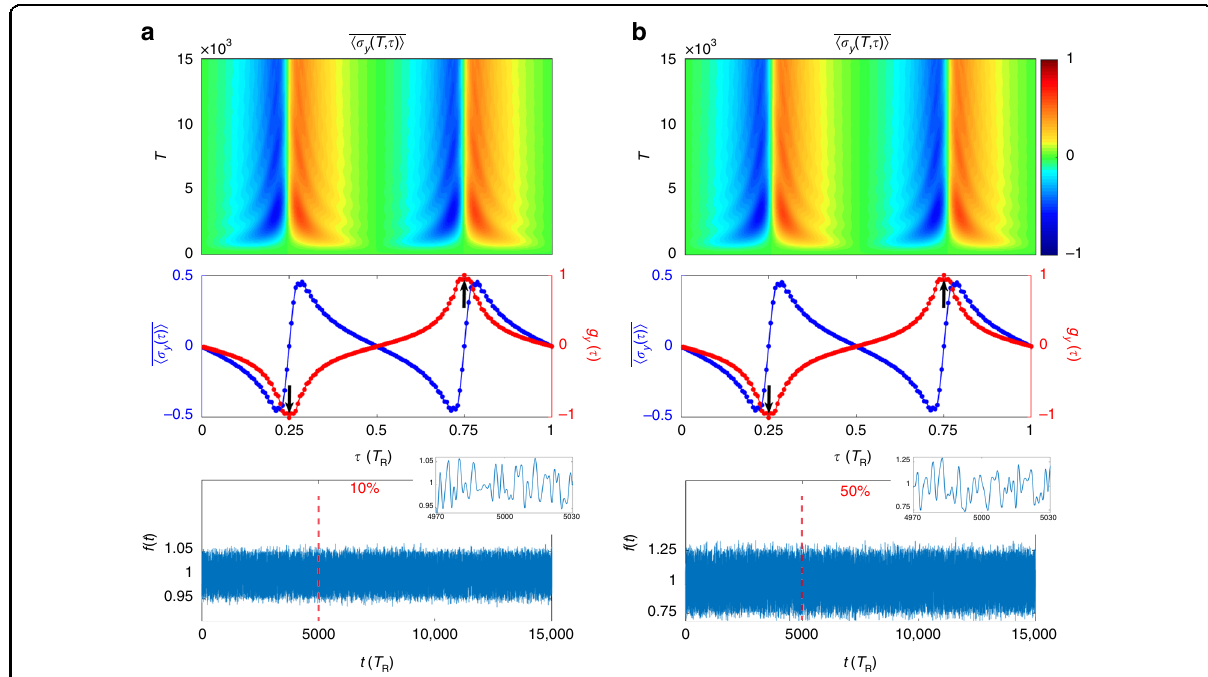
Fig. 4 The time evolution of the normalized spin textures with disorders in the phase modulator. The evolution of averaged spin polarization h σ y ð T ; τ Þi , the overall spin polarization h σ y ð τ Þi , the dynamical spin texture g y ð τ Þ , respectively, with parameters for Fig. 3a, b and disorder function f ð t Þ in κ ð t Þ and κ ′ ð t Þ with δ ¼ 10 % ( a ) and 50 % ( b ), respectively. Black arrows point to values of g y ð τ 1 ; 2 Þ